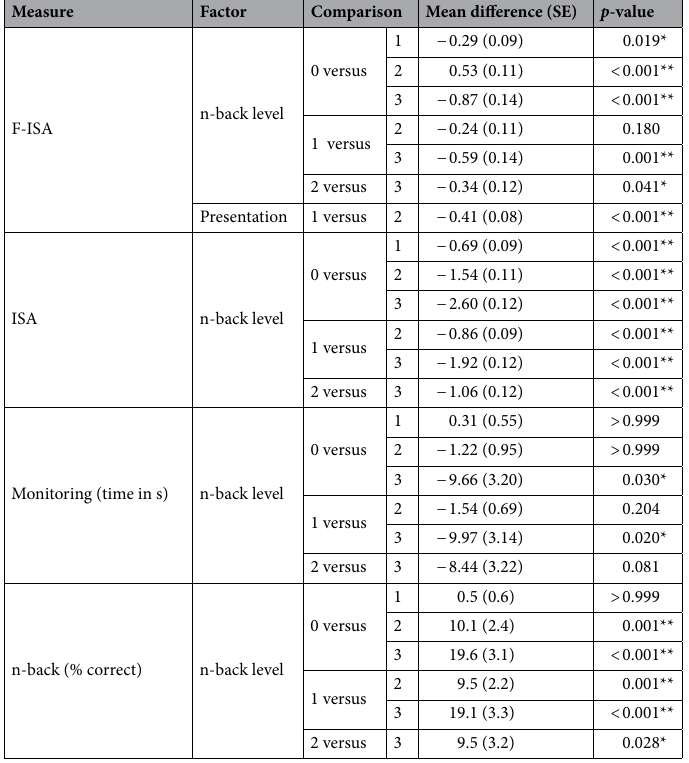
Table 2. Bonferroni-corrected post-hoc pairwise comparisons for subjective and performance measures. Significance levels marked p < 0.05* and p <